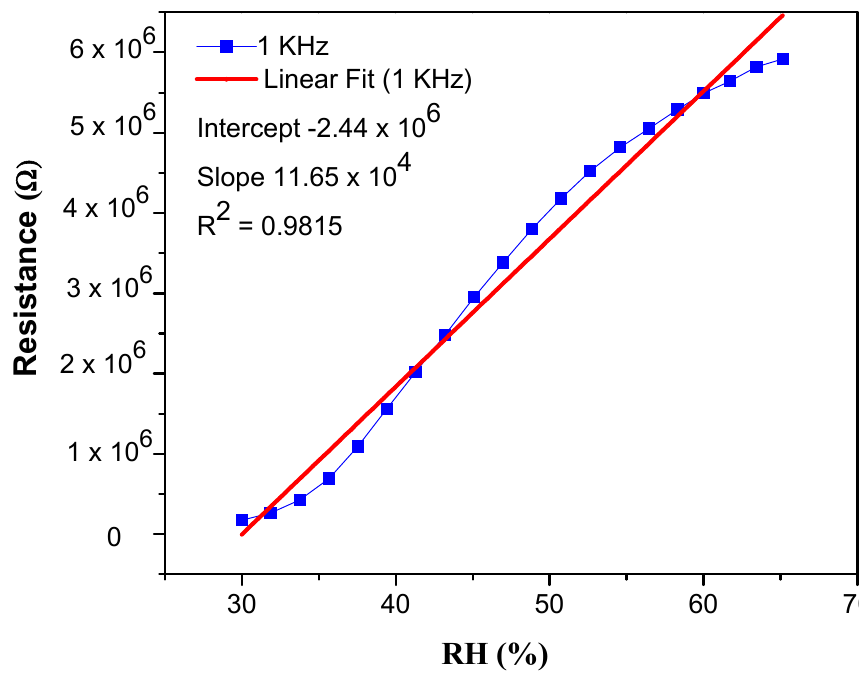
Figure 5. Resistive linearity of PEO − CuO − MWCNT: 1% nanocomposites.